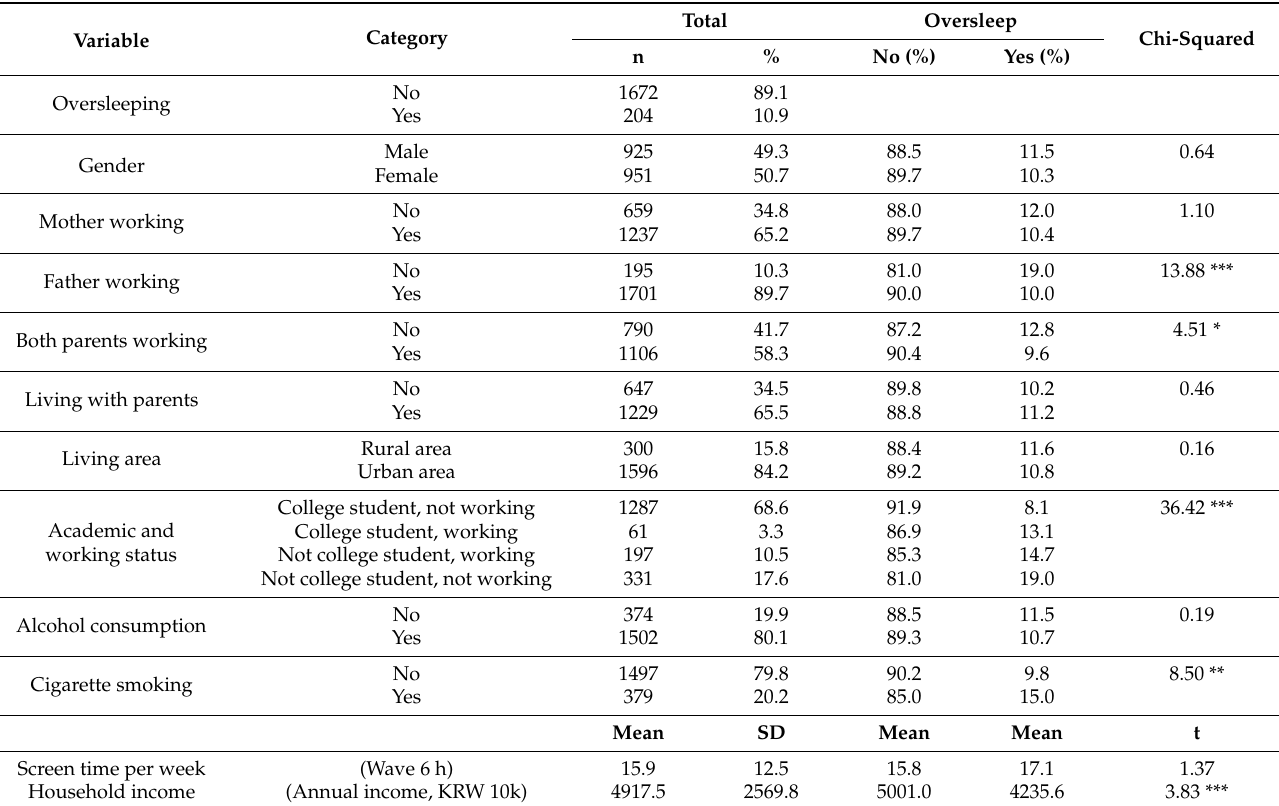
Table 1. Sample characteristics and proportion of Korean young adults who experienced oversleeping by various related factors ( n =